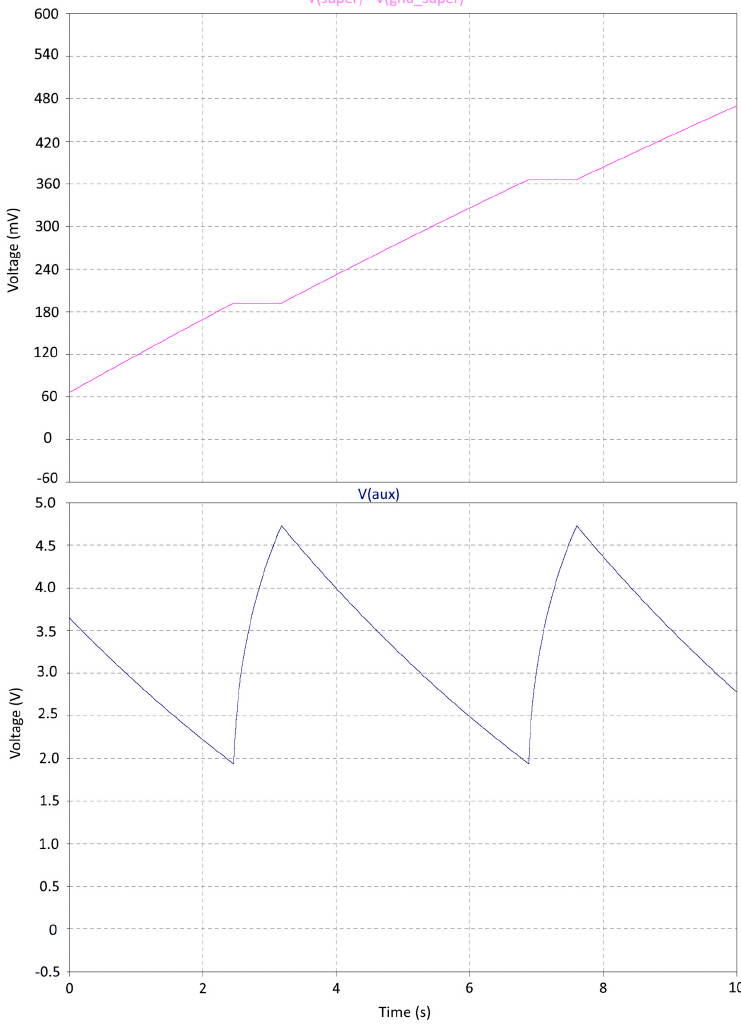
Figure 13. Results of the simulation for the simplified circuit of Figure 12. The input signal is a piecewise linear function approximating a real case. The waveforms show the charging sequence: Vaux (bottom trace) and Vsupercap (upper trace).